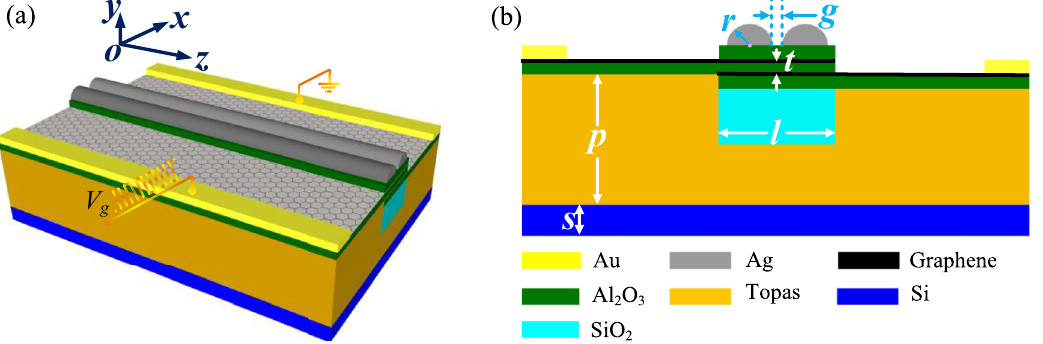
Figure 1: Schematic configuration of the GPM. (a) 3-D schematic illustration, (b) cross-sectional view. The structure dimensions are set as s = 100 nm, p = 800 nm, l = 600 nm, t = 5 nm, r = 100 nm, and g = 10